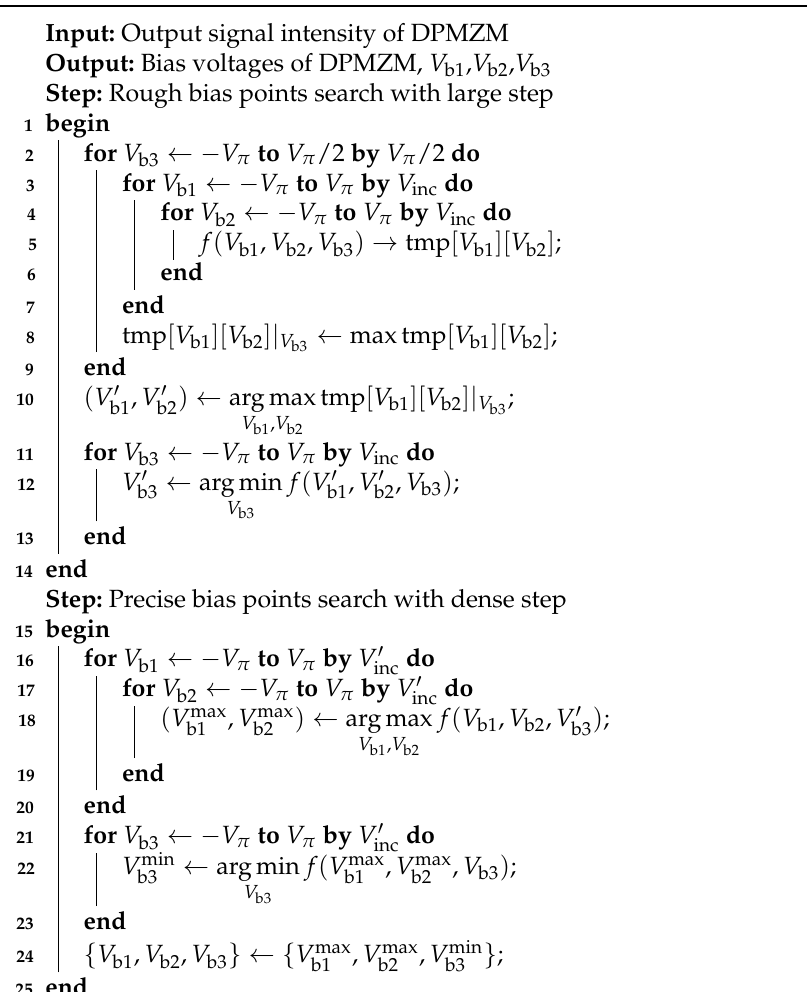
Algorithm 1: Bias points searching